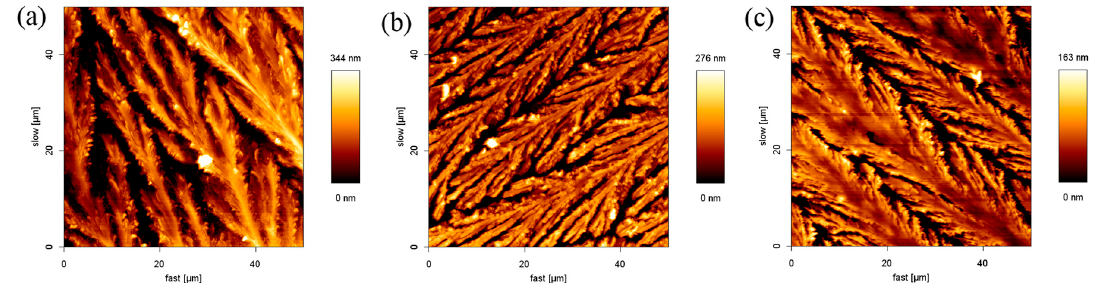
Figure 4. AFM images of SDS-inorganic salt aggregates on the surface of the glass: ( a ) SDS-NaCl; ( b ) SDS-NaI; and ( c ) SDS-NaNO 2 .